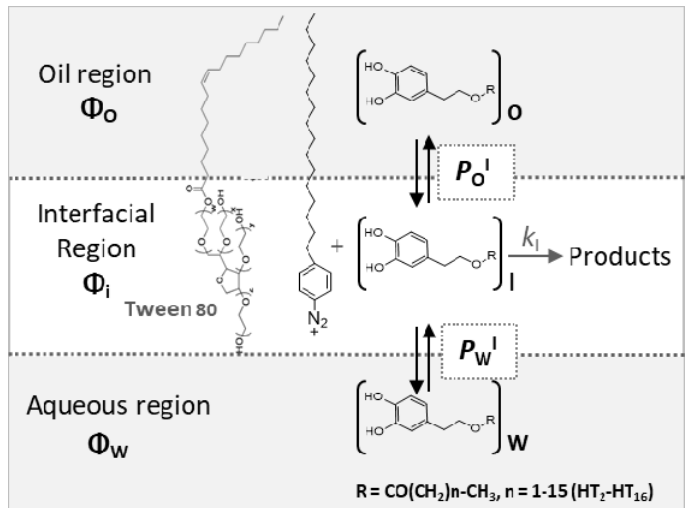
Figure 1. Partition of hydroxytyrosol (HT) and its ester derivatives (AO) between the different regions of a model emulsified system. P O I = partition constant of the AO between oily region and interfacial region, P WI = partition constant of the AO between aqueous region and interfacial region, and k I = rate constant for the reaction between 16-ArN 2+ and the AO in the interfacial region. Φ refers to the volume fraction of an aqueous ( Φ W ), interfacial ( Φ I ), and oil ( Φ O ) regions.